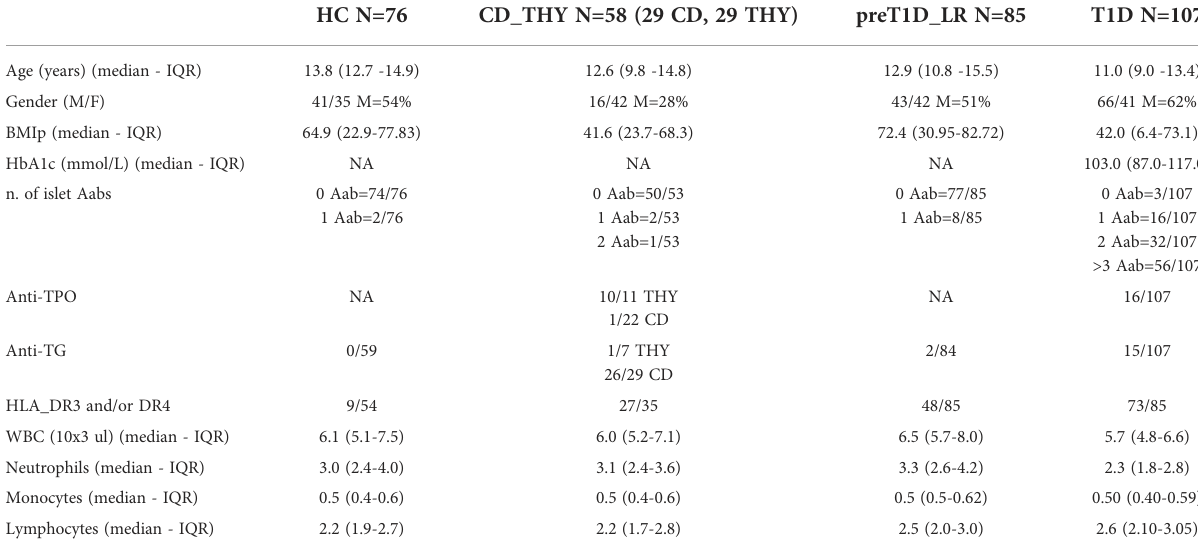
TABLE 1 Characteristics of the study